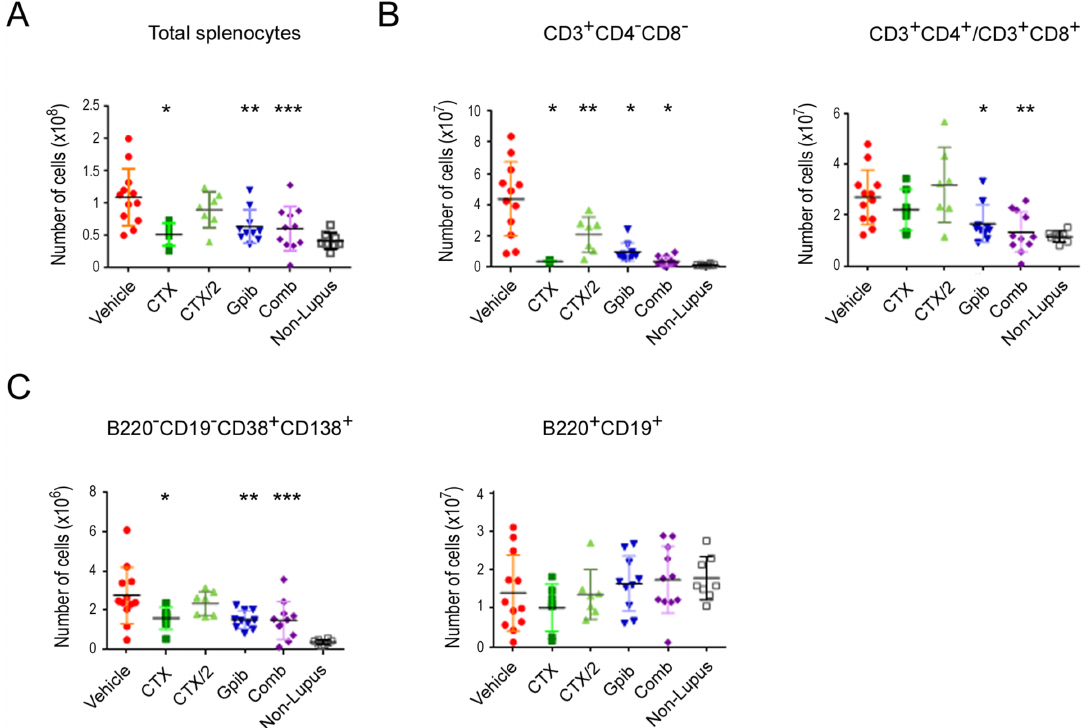
Fig 6. Ganetespib-based therapies suppress splenic expansion of activated T cells and abnormal plasma cells. (A) Plot shows the total number of splenocytes. Data are shown for 7 – 12 mice per treatment group. ( * p < 0.007; ** p < 0.0037; *** p < 0.0012 versus vehicle-treated animals). (B) Splenocytes were isolated, counted and analyzed for the total number of CD3 + CD4 - CD8 - T cells ( left panel ; * p < 0.0001, ** p < 0.0004) or the number of mature phenotype CD3 + CD4 + and CD3 + CD8 + T lymphocytes ( right panel ; * p = 0.04, ** p = 0.002). (C) Numbers of B220 - CD19 - CD38 + CD138 + plasma cells ( left panel ; * p = 0.03, ** p = 0.007, *** p = 0.004) and B220 + CD19 + B cells ( right panel